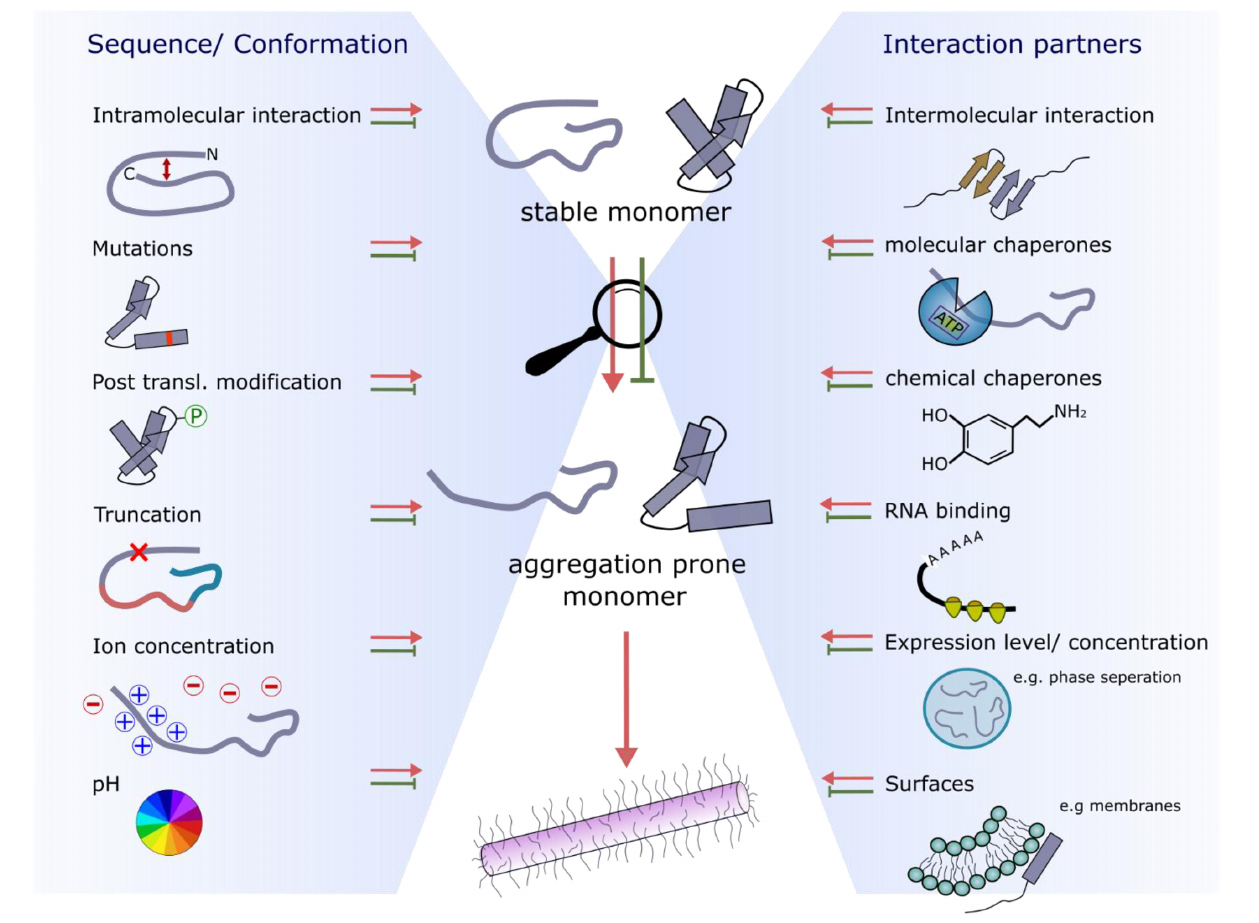
FIGURE 4 | Factors affecting the conformational properties and interactions with amyloid precursors that retard or accelerate fibril growth. The two main influences are sequence/conformation-dependent (left-hand side) or occur as a result of binding to interaction partners (right-hand side)